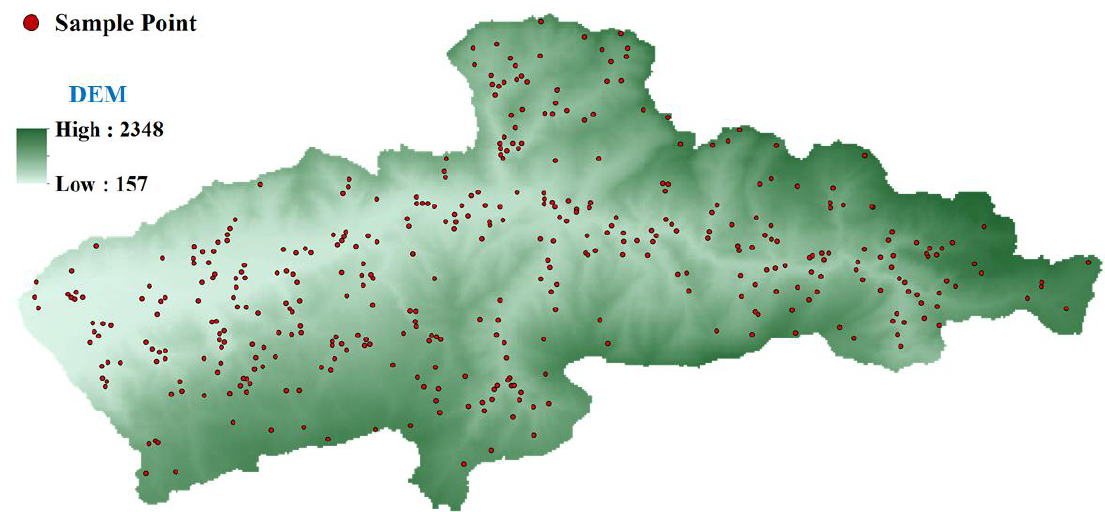
Figure 3. Distribution of data samples in the case study.